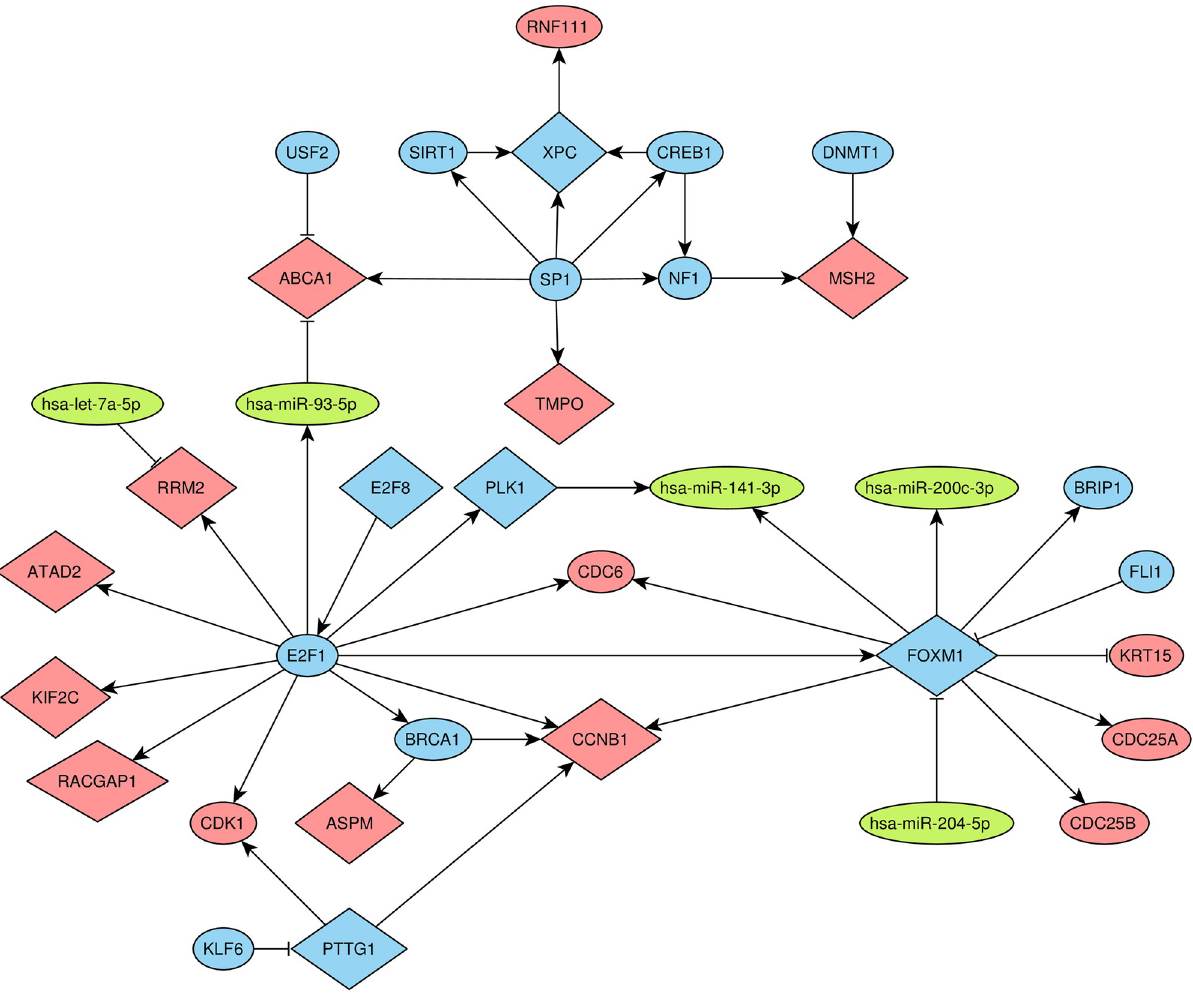
Fig 6. Neighborhood of genes overrepresented in prognostic signatures. Diamond-shaped nodes correspond to fourteen overrepresented genes. Blue nodes correspond to TFs, red nodes correspond to genes, green nodes correspond to miRNAs. The arrows and T-shaped lines signify activation and repression,